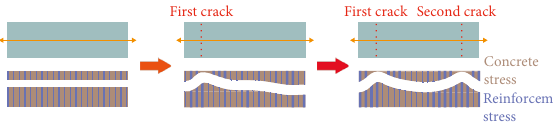
Figure 1: Axial stressed